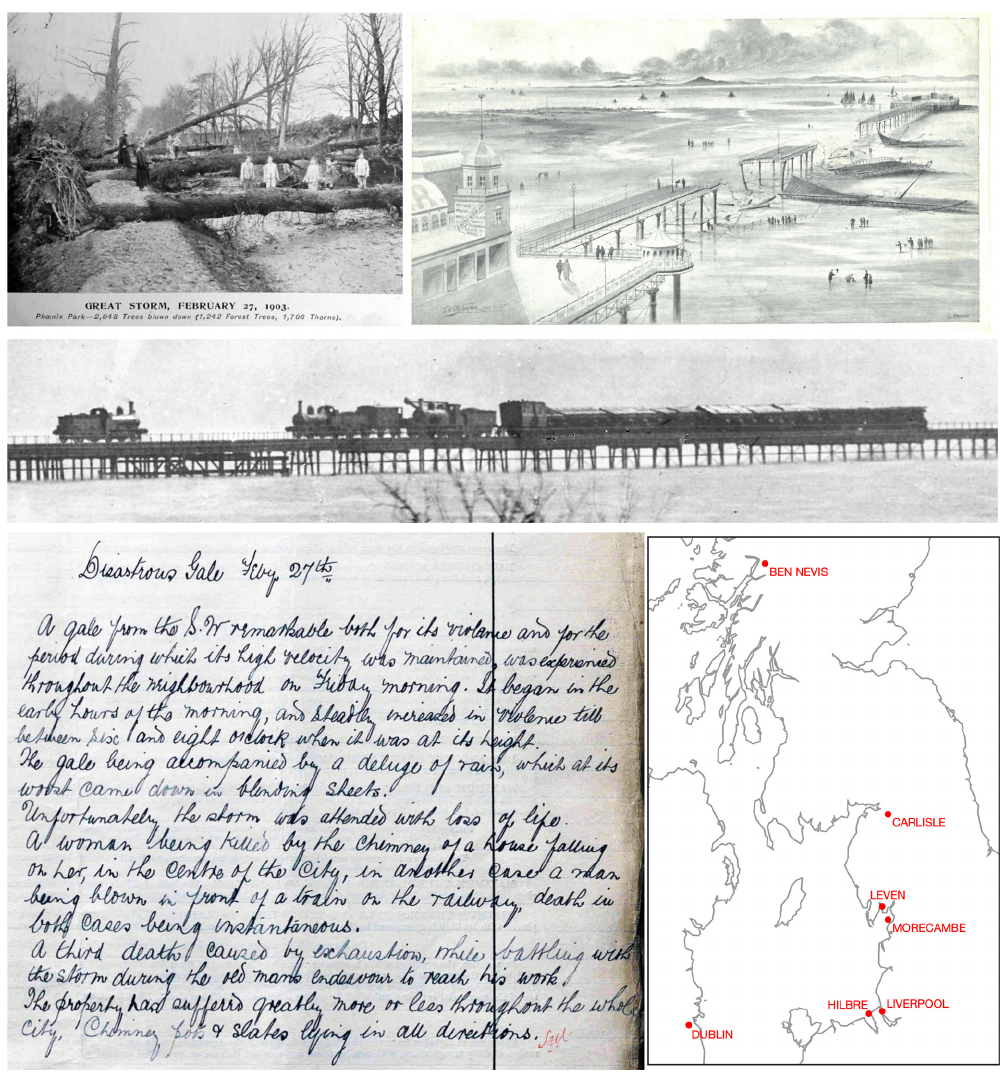
Figure 2. Visual descriptions of damage from Storm Ulysses. Top: photographs from Dublin (left) and Morecambe (right). Middle: photo- graph of a train blown over on Leven viaduct. Bottom: written account of the storm in Carlisle and a map of locations in the photos or named in the text. The Dublin image was supplied by Aida Yared. The Leven photograph was taken by a Mr Alexander, assistant engineer for the Furness railway. The Morecambe image is a scan of a postcard owned by one of the paper